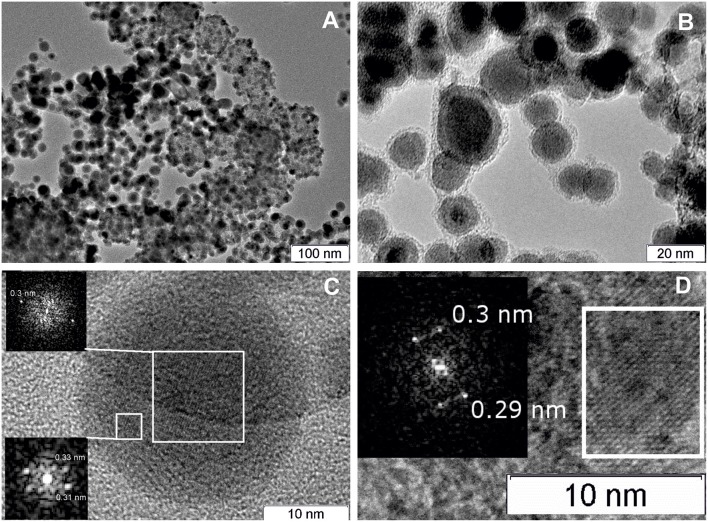
TEM image of the PtCeSnC composite (A), TEM image of large core-shell-shell particles (B). HRTEM image and Fourier image of the lattice of core-shell-shell particles Sn@SnO2@C (C). HRTEM image and Fourier image of the crystal lattice of small Ce2O3 particles within amorphous carbon matrix (D).